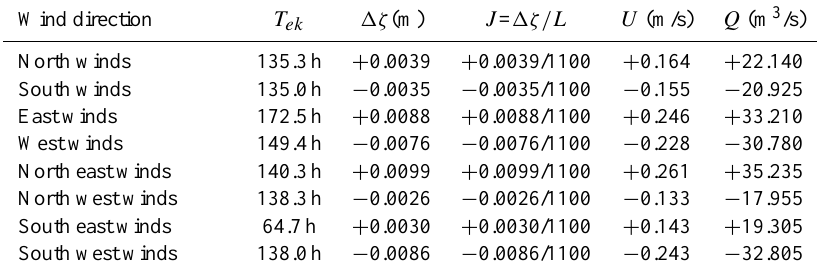
Table 1. Time, T ek , required for the hydrodynamic circulation to reach steady-state conditions, Elevation Difference, 1ζ , between the two channel openings, Energy gradient J , Current Velocity U and Flow Rate Q , in the channel for different